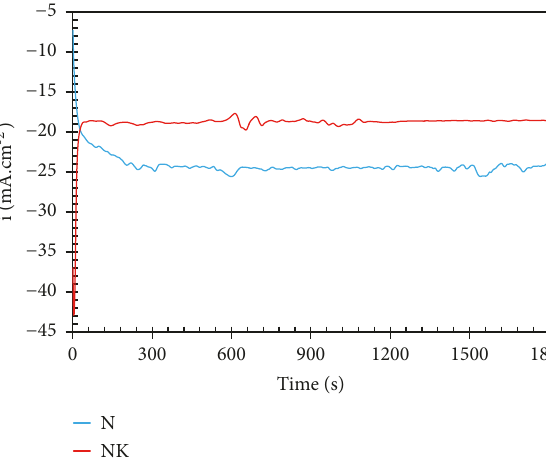
Figure 7: Variation of the current density with the treatment time for the electrochemically nitrided samples.